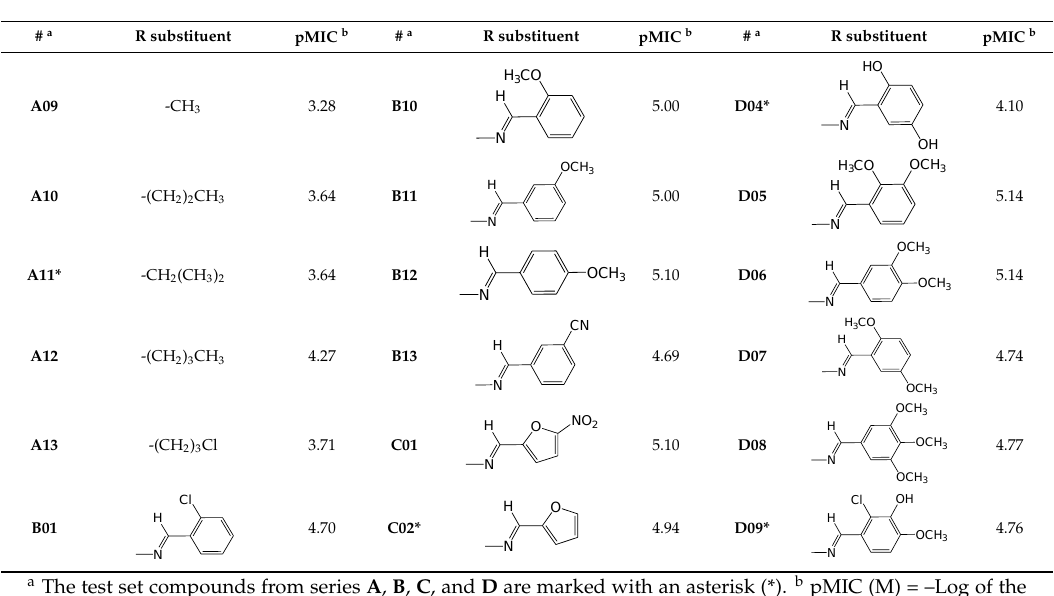
Table 3. Summary of hologram quantitative structure–activity relationship (HQSAR) statistical indexes for various fragment distinction (FD) parameters using the default fragment size (FS = 4–7 atoms) for both tautomers I (amino) and II (imino) data sets.